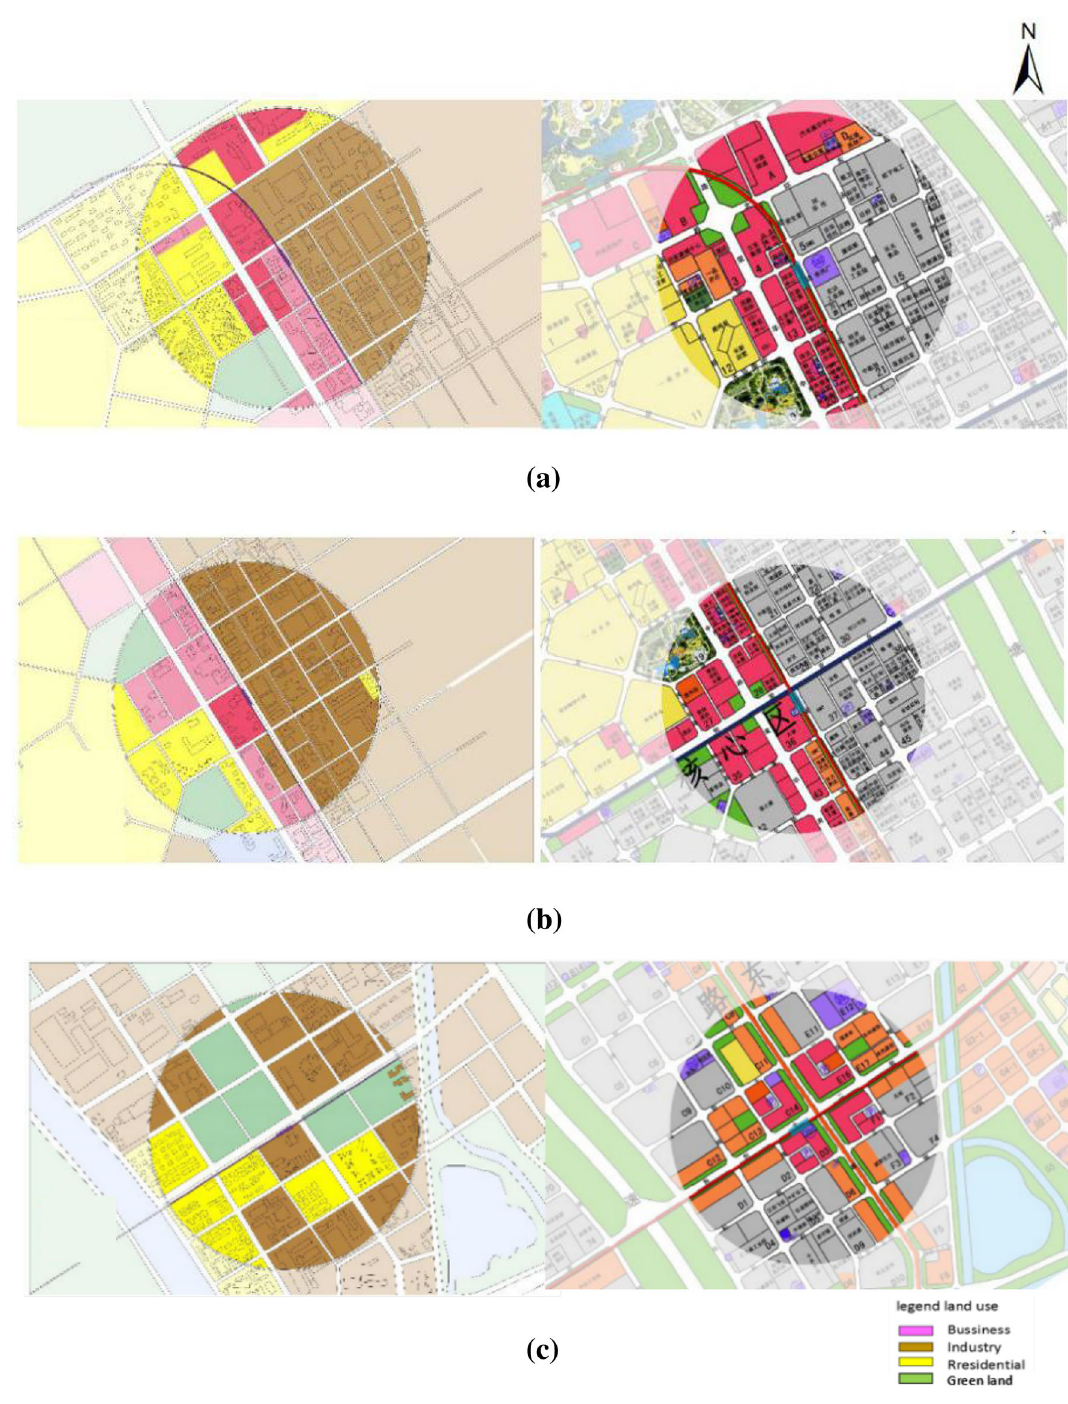
Fig. 4 Actual ( left ) and planned ( right ) land use around three light rail stations Table 2 Land use surrounding three stations in